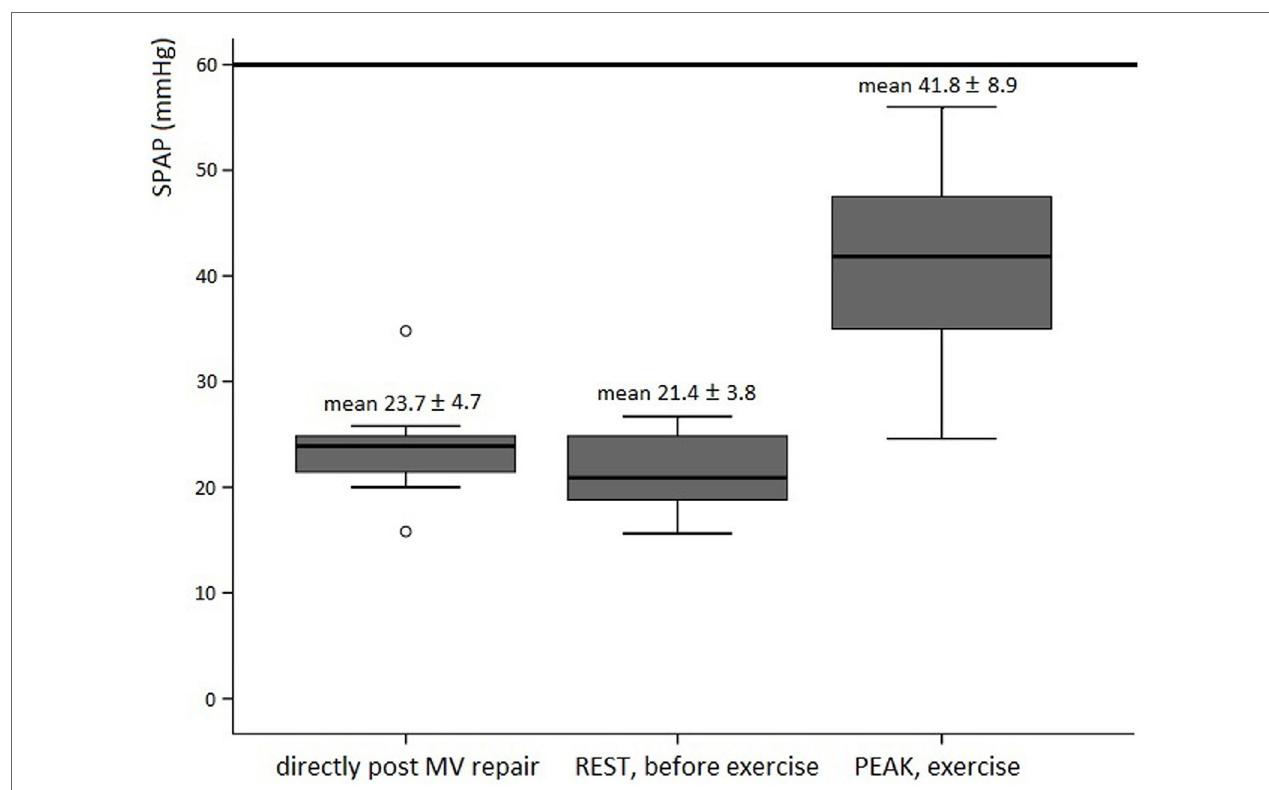
FigUre 2 | Boxplot figures showing the SPAP directly post MV repair ( n = 11), at rest ( n = 8), and peak exercise ( n = 14) in asymptomatic patients post MV repair. The reference line (thick line) is the current recommendation for intervention in native valve disease (3, 4). Abbreviations: SPAP, systolic pulmonary artery pressure; MV, mitral